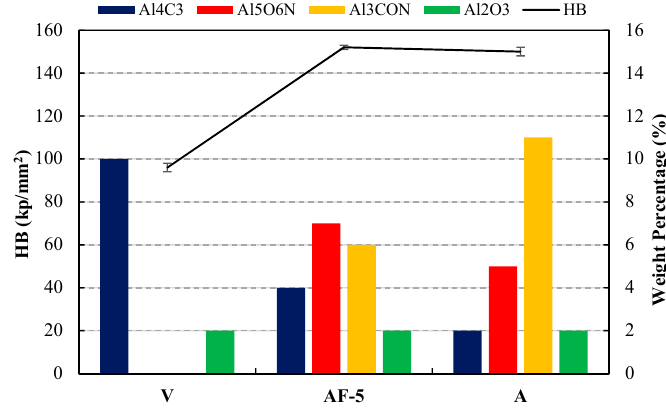
Figure 7. Hardness and weight percentage of the second phases formed in the different sintered samples.